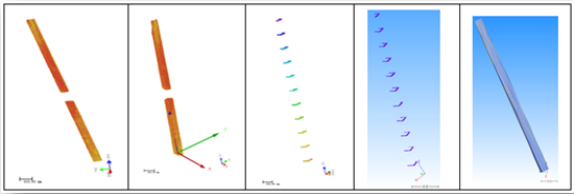
Figure 5e : Four planes model